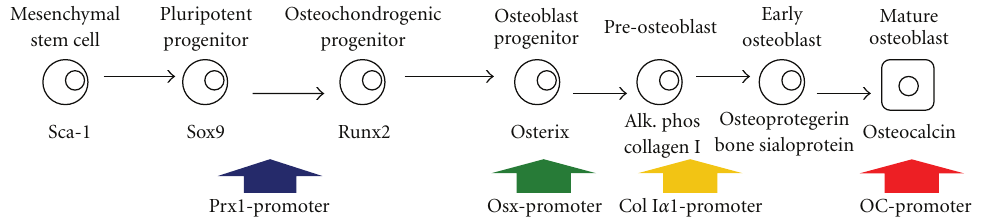
Figure 3: Osteosarcomagenesis has been tested from a range of cells of origin along the di ff erentiation pathway of osteoblasts. Cre - recombinase expression driven from the Prx1 , osterix , and collagen 1a1 promoters has generated osteosarcomas in mice when used for the conditional inactivation of p53 with or without Rb1 . The osteocalcin promoter, defining a late stage of osteoblast di ff erentiation usually not expressed in osteosarcoma cells directly, has proven su ffi cient for osteosarcomagenesis, when used to drive SV40 large and small T